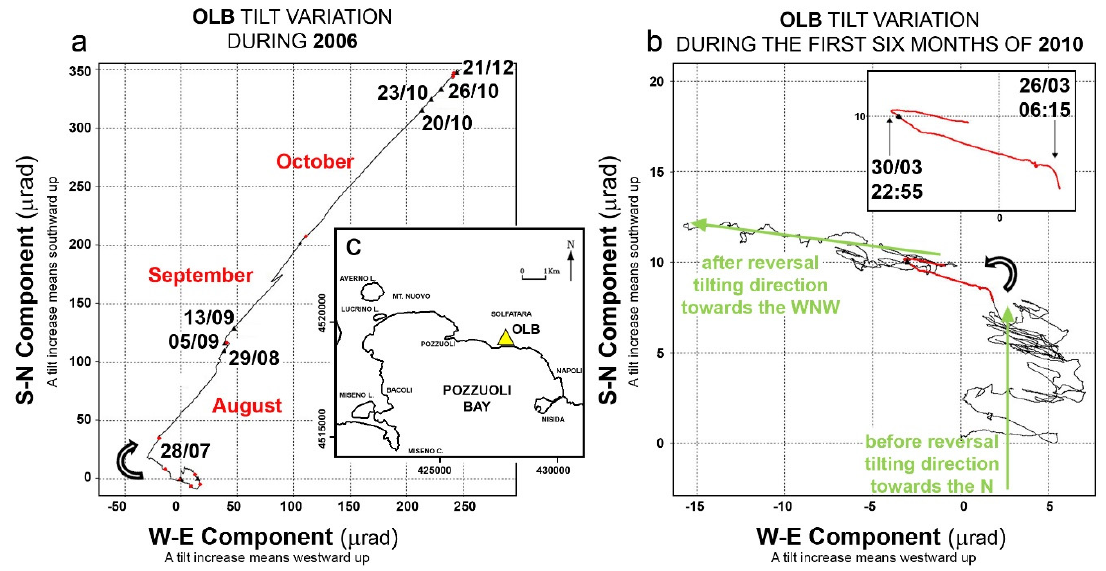
Figure 6. Plots of the tilt vector recorded at OLB before two seismic swarms. ( a ) The tilt reversal observed in late July 2006, indicated with a semicircular right arrow, takes place before the seismic events of September and October of the same year. ( b ) The tilt reversal recorded on 26 March 2010 indicated in red with a semicircular left arrow, occurs four days before the seismic swarm of late March of the same year and interrupts the tilting towards the N, forcing it towards the W. The inset shows the zoom of the tilt reversal and the arrows placed on the hodograph show the direction of ground tilting. ( c ) Location of the OLB tilt station.